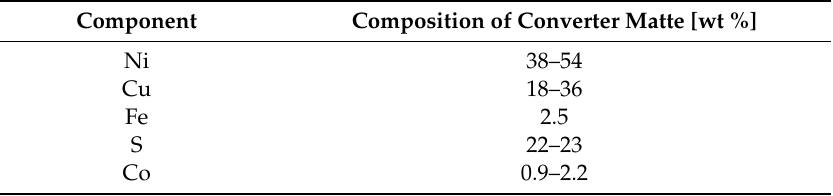
Table 4. Composition of mattes entering Glencore Nikkelverk AS [50].